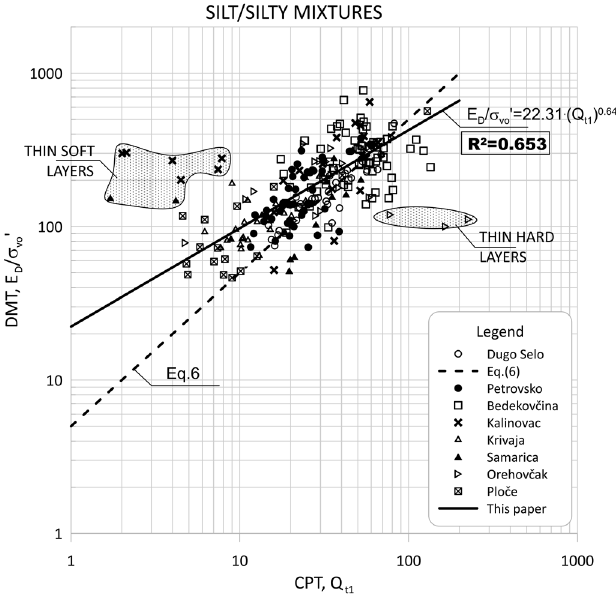
versus 𝑄𝑄 𝑡𝑡1 𝐸𝐸 𝐷𝐷 𝜎𝜎′ 𝑣𝑣0 ⁄